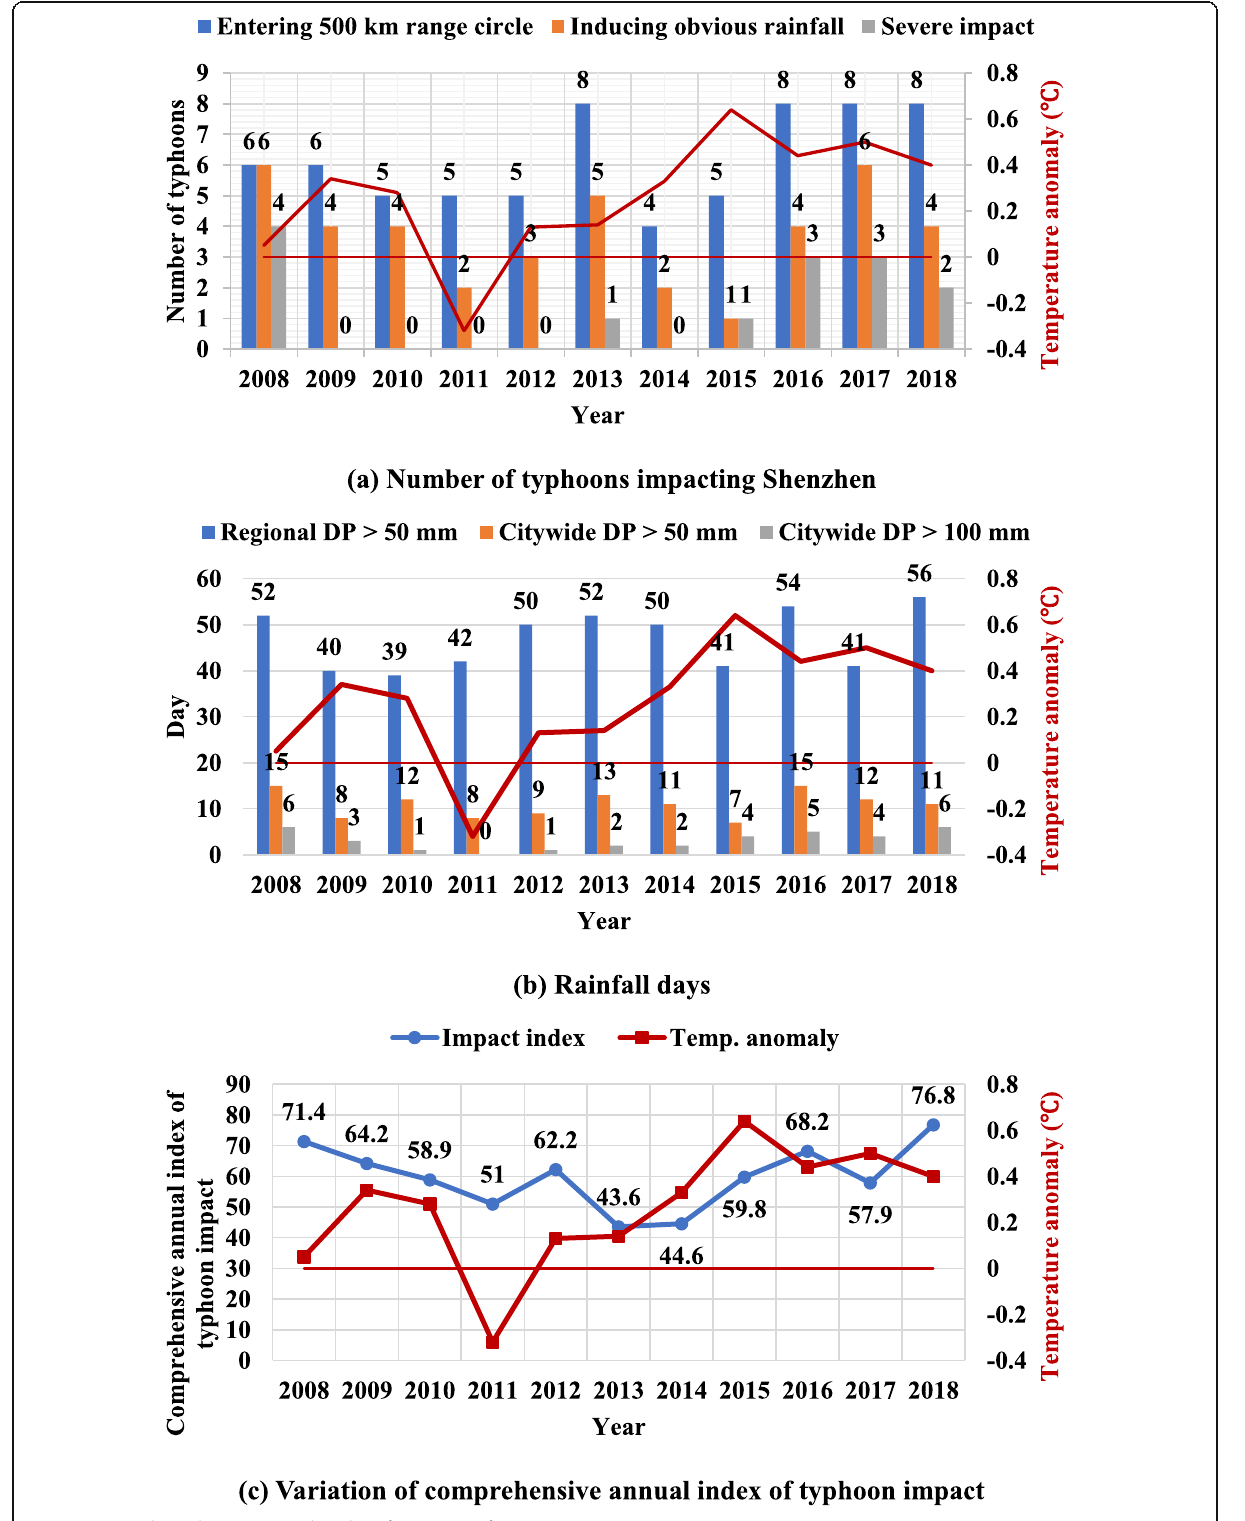
Fig. 5 Meteorological variation in shenzhen from years of 2008 to 2018